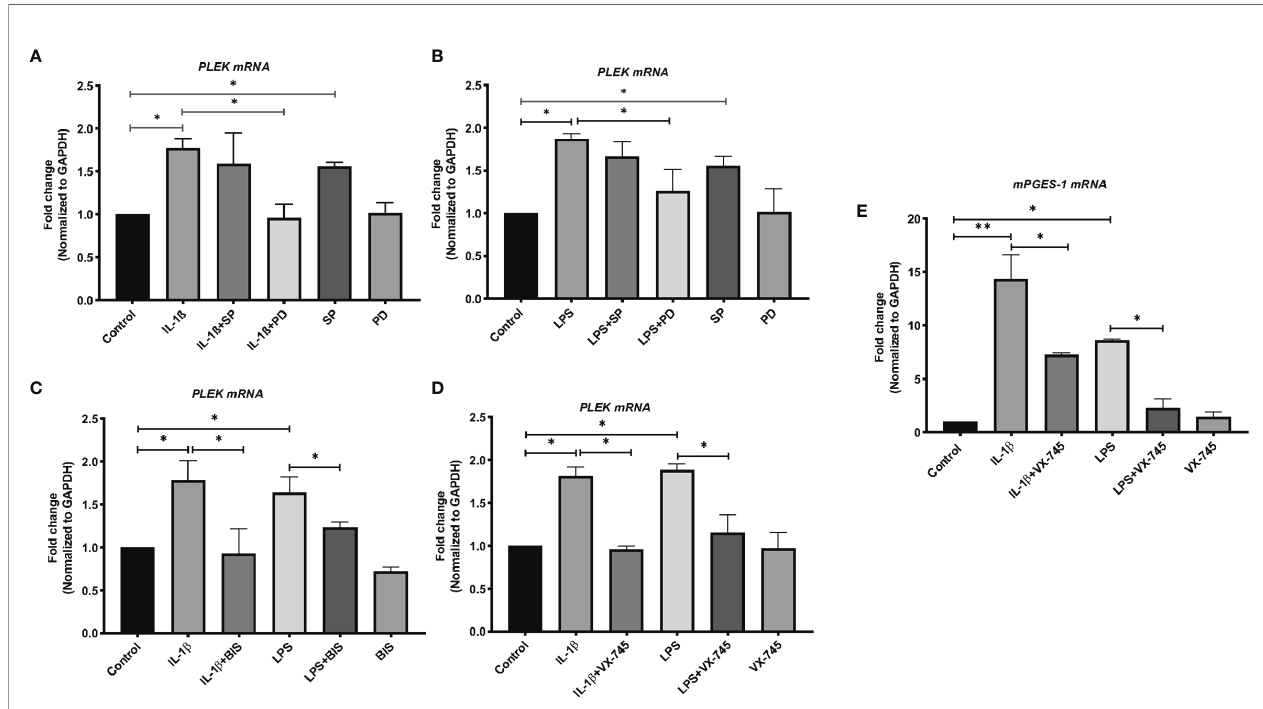
FIGURE 3 | Bar graphs of relative mRNA levels (fold change) of PLEK and mPGES-1 by qPCR. (A) PLEK mRNA levels in HGFs (0.3x10 6 cells/ml) stimulated with IL-1 b (500 pg/ml) for 24 h alone or in combination with SP (20 m M) or PD (2 m M). (B) PLEK mRNA levels in gingival fi broblasts stimulated with P. gingivalis LPS (5 m g/ ml) alone or in combination with SP or PD. (C) PLEK mRNA levels in HGFs stimulated with IL-1 b or LPS alone or in combination with BIS. (D) Gingival fi broblast cells were stimulated with IL-1 b and/or LPS alone or in combination with VX-745 (1.0 µM) for 24 h, followed by measurement of relative mRNA levels (fold change) of PLEK . (E) mPGES-1 mRNA level after IL-1 b and LPS treatment alone or in combination with VX-745. The relative mRNA levels were normalized to the levels of the housekeeping gene GAPDH. Data are presented as mean values ± SD from at least three independent experiments. Signi fi cance was calculated with one-way ANOVA with Tukey ’ s multiple comparisons test where p-values were set as *p ≤ 0.05 and **p ≤ 0.01. SP, SP600125 (inhibitor of c-Jun N-terminal kinase JNK); PD, PD 153035 hydrochloride (inhibitor of the epidermal growth factor receptor tyrosine kinase EGFR); BIS, Bisindolylmaleimide I, Hydrochloride (Protein kinase